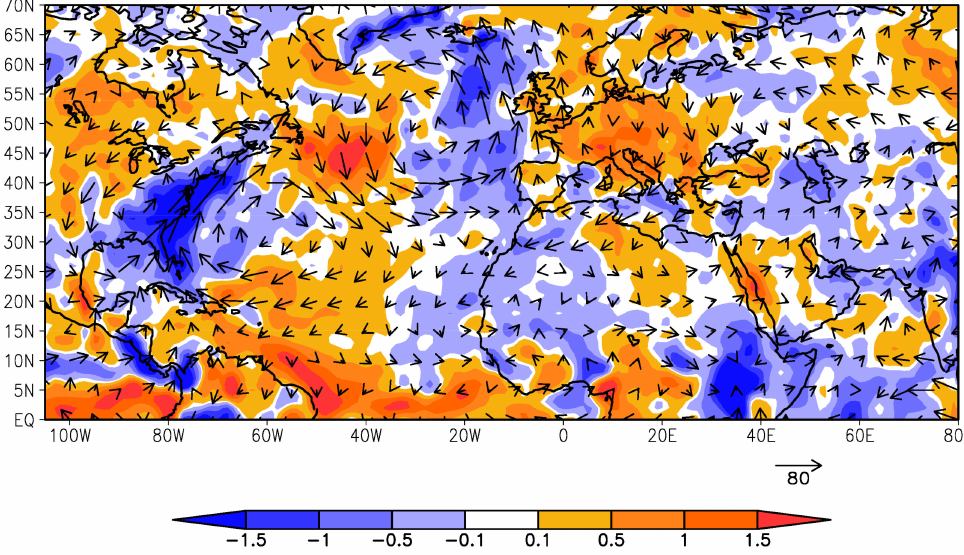
Figure 7. Anomalies of ERA-Interim vertically integrated moisture flux (vector, kg/m/s) and its respective divergence (shaded, mm/day) averaged for the 2003